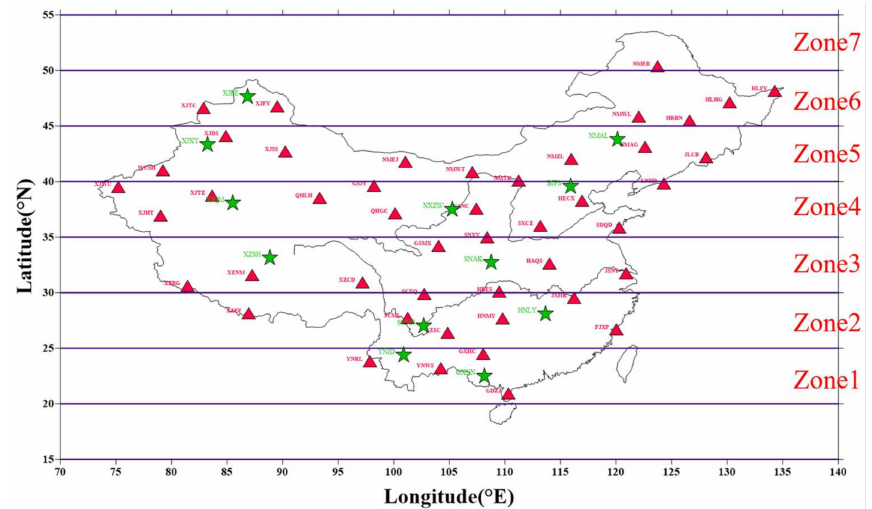
Figure 1. Distribution of the 58 GNSS stations used in this work (the red triangles represent the stations used to improve the IRI-2016 model, and the green five-pointed stars represent the stations used to evaluate the improvement effect on the IRI-2016